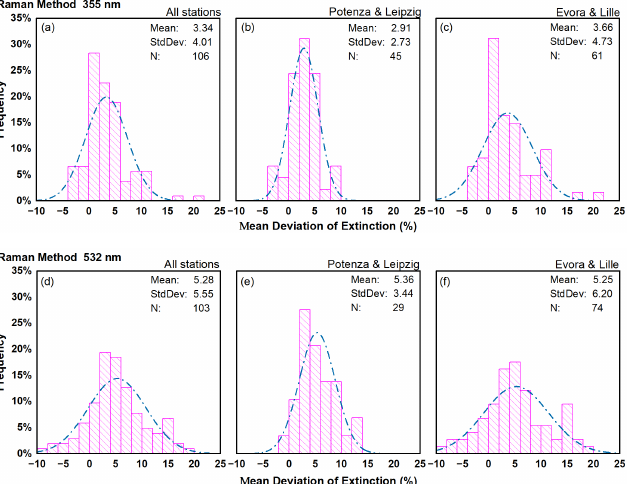
Figure 10. The frequency distributions of the mean relative deviation of extinction from all the cases at 355 nm and 532 nm ( a , d ), together with IFS_ECMWF vs. ERA5 (for Potenza and Leipzig stations) at two wavelengths ( b , e ) and GDAS vs. ERA5 (for Evora and Lille stations) at two wavelengths ( c , f ). The dotted line shown in the subfigure is the Gaussian fitting curve.